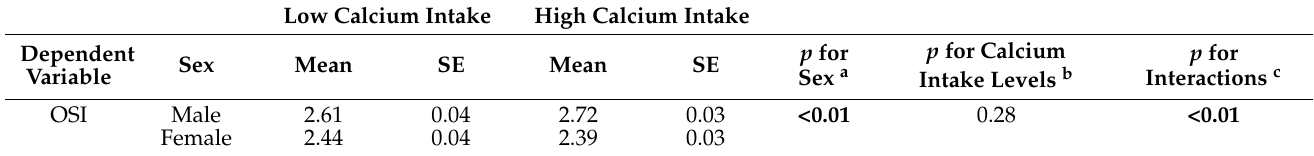
Table 3. Interaction between sex and calcium intake levels on the OSI.